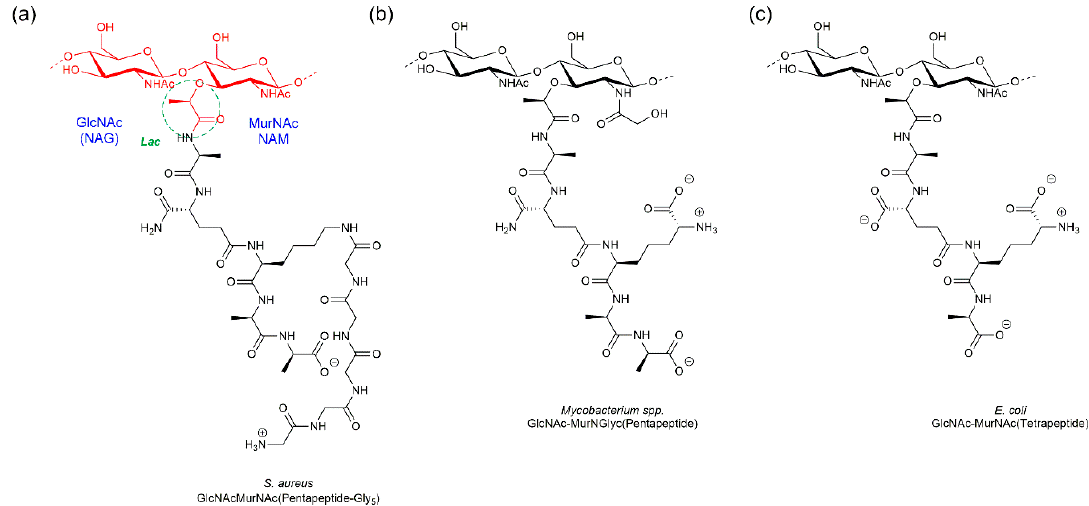
Figure 1. Representation of the monomeric muropeptides frequently found in the peptidoglycan (PGN) of different bacteria. ( a ) the structure of the Staphylococcus aureus PGN (a Lys-type PGN) unit is presented. N -acetylglucosamine (NAG)– N -acetylmuramic (NAM) disaccharide units (red) are linked to each other via NAG-( β -1,4)–NAM linkage. Stem peptides (black), of which the composition is specific for each bacteria species, are attached to the D -lactyl (Lac – highlighted in the green circle) moiety of each NAM. The sequence of the peptide stem attached to the lactyl carboxylate of NAM is L -Ala- D -iGln- L -Lys- D -Ala- D -Ala. ( b ) the structure of a muropeptide of Gram-positive Mycobacterium spp., with an L-Ala-D- i Gln- meso -DAP- D -Ala- D -Ala stem peptide sequence. ( c ) a representative muropeptide of the Gram-negative bacterium Escherichia coli .